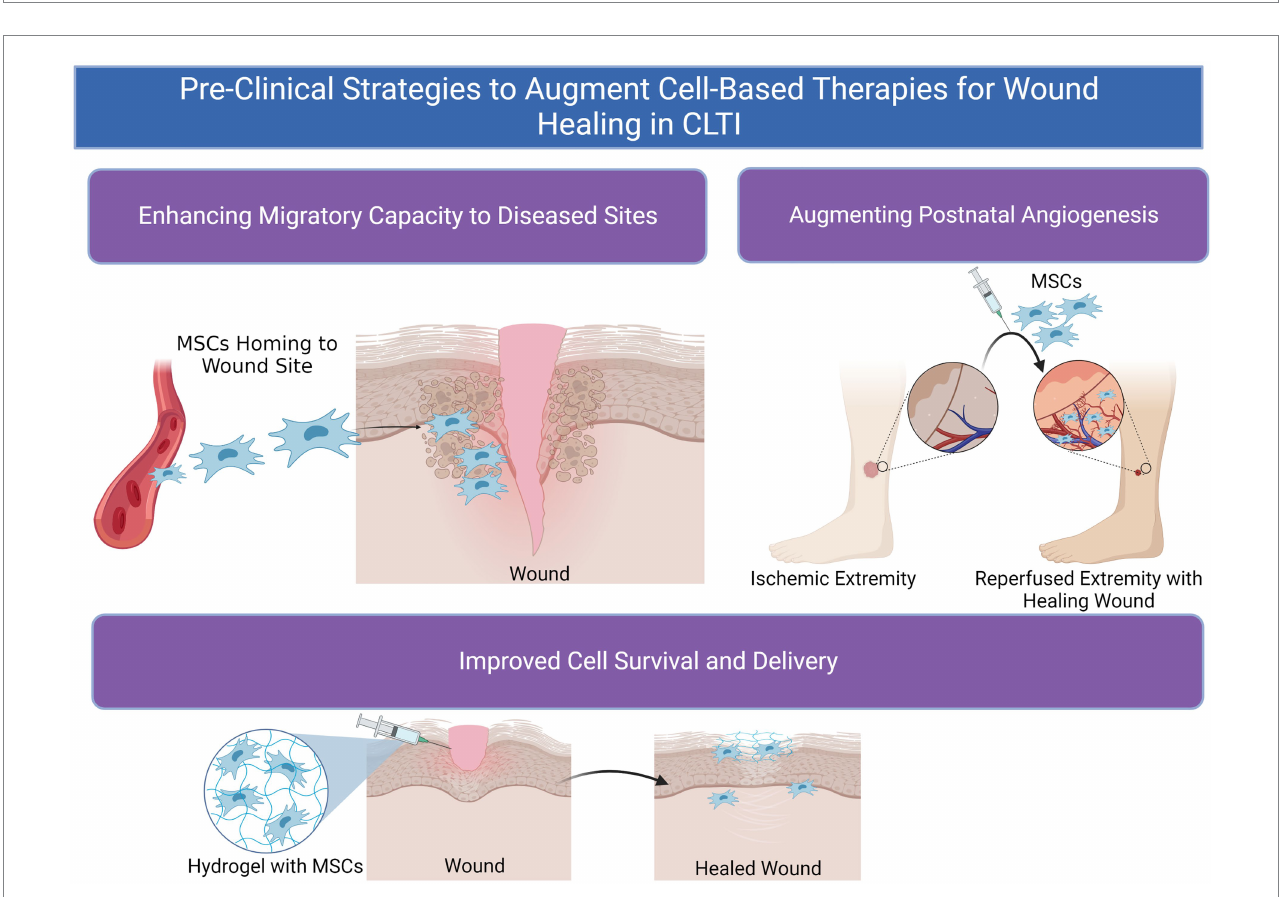
FIGURE 3 Pre-clinical methods to augment cell-based therapeutics for wound healing in chronic limb-threatening ischemia